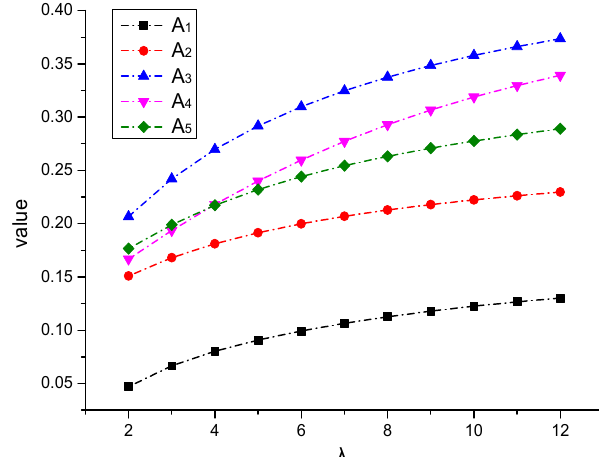
Figure 4. The influence of the change of λ value based on Gq-RONFOWA operator on the sorting result.